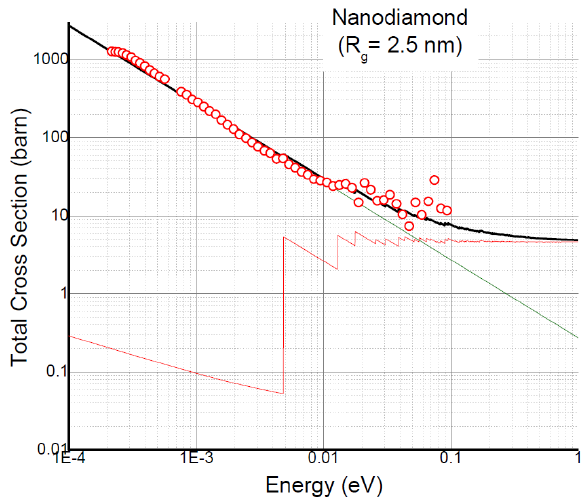
Fig. 4 : Total cross section of nanodiamond, comparing our calculated curve (black line) with experimental data from Ref.[10]. Red and green lines denote the crystal and SANS components, respectively.